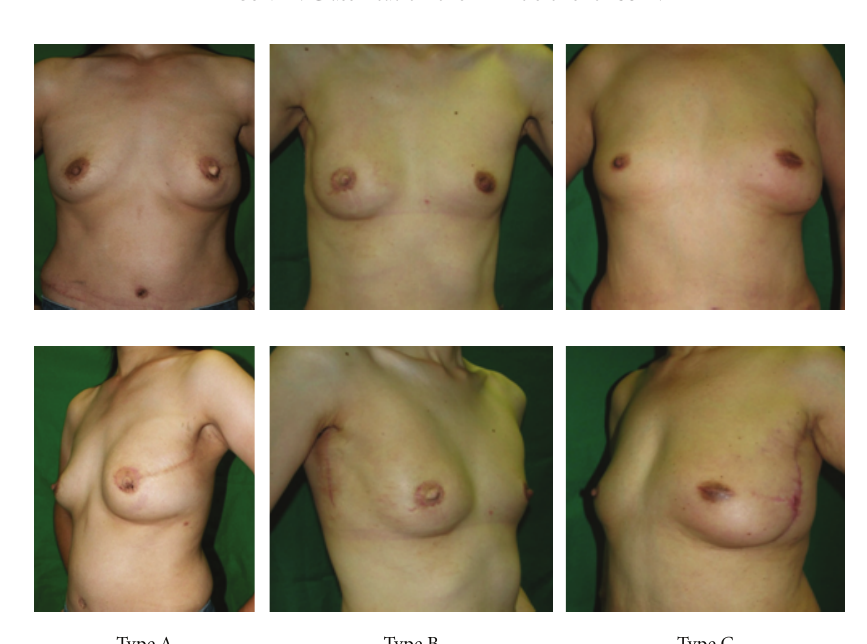
Figure 2: Appearance of the breast following SSM and reconstruction with a TRAM flap. Type A: left breast, type B: right breast, and type C: left breast.